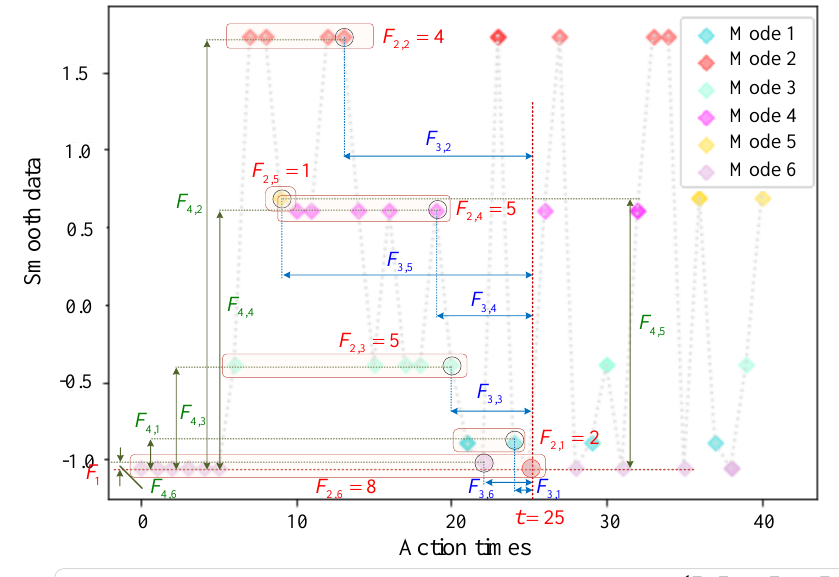
Figure 2. The example of cumulative dynamic physical difference feature construction. Calculate the proposed features of t = 25. Compared points are the last action times of all modes. F 1 is the value of smooth data. F 2,1 , F 2,2 . . . F 2,6 is the cumulative time of each mode. F 3,1 , F 3,2 . . . F 3,6 are the difference times to compared points. F 4,1 , F 4,2 . . . F 4,6 are the difference data to compared